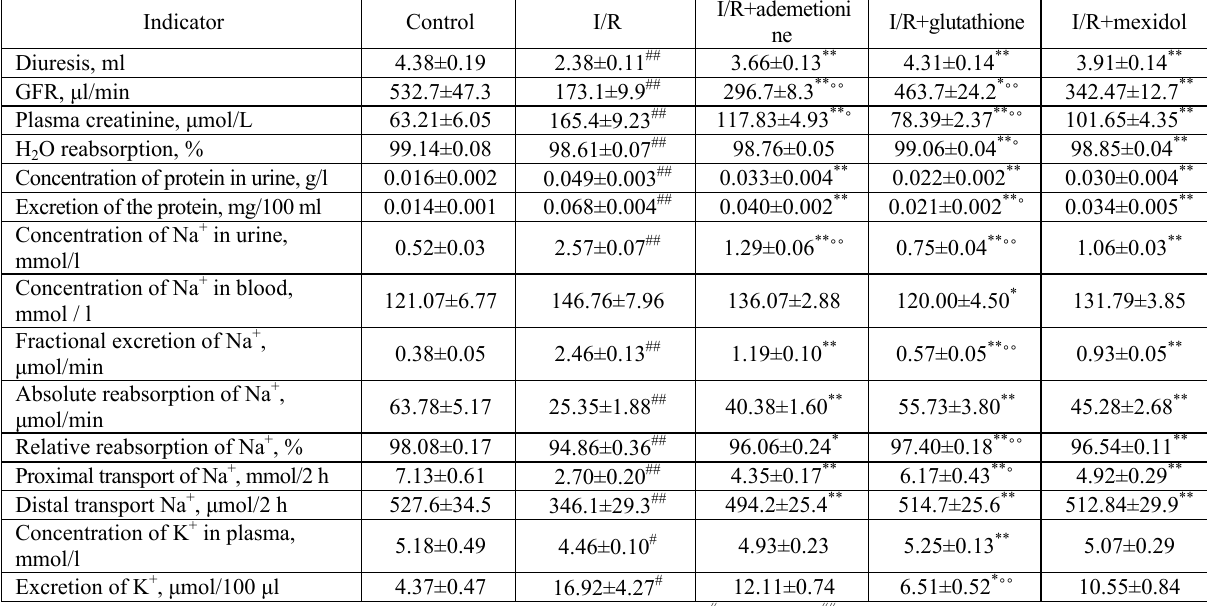
Functional state of kidney of rats at application of ademetionine and glutathione on the background of